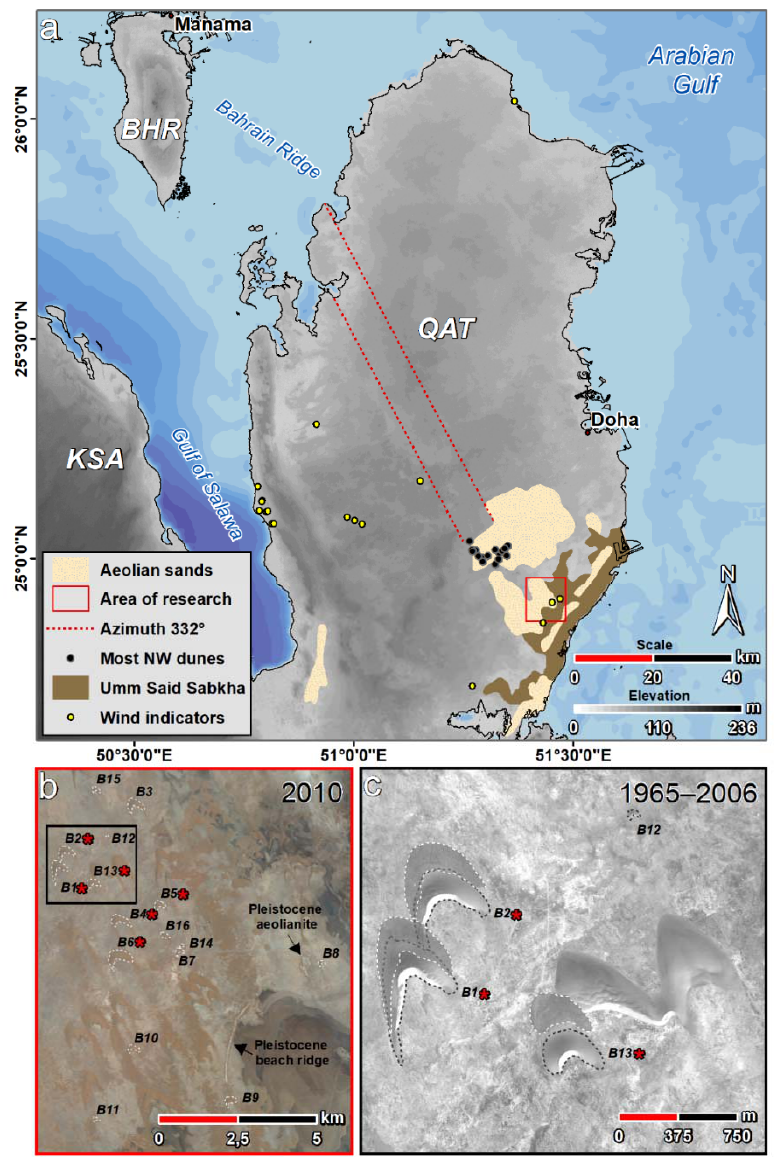
Figure 1. ( a ) Overview of the Qatar peninsula based on SRTM30 data [8] and the GEBCO_2014 grid [9] showing the location of the distribution of aeolian surface deposits (mostly in the form of barchanoid dunes), the core study area within the barchan dune fields, the associated downwind Umm Said sabkha, the former main sediment source areas of the shallow Bahrain Ridge and northern Gulf of Salwa, the main corridor of barchan migration in the past (azimuth 332° deviation from N after [10]), and the distribution of long ‐ term geomorphic indicators of Shamal predominance. The most NW dunes were used to infer the timing of the loss of sand supply; ( b ) Core study area with barchan dunes B1–B16 (based on Landsat ‐ 7, courtesy of the U.S. Geological Survey). Dunes mined between 2006 and 2015 are marked with red asterisk; ( c ) Examples of dune migration towards SSE between 1965 (Gambit KH ‐ 7) and 2006 (OrbView ‐ 3) (cf. Table 1).